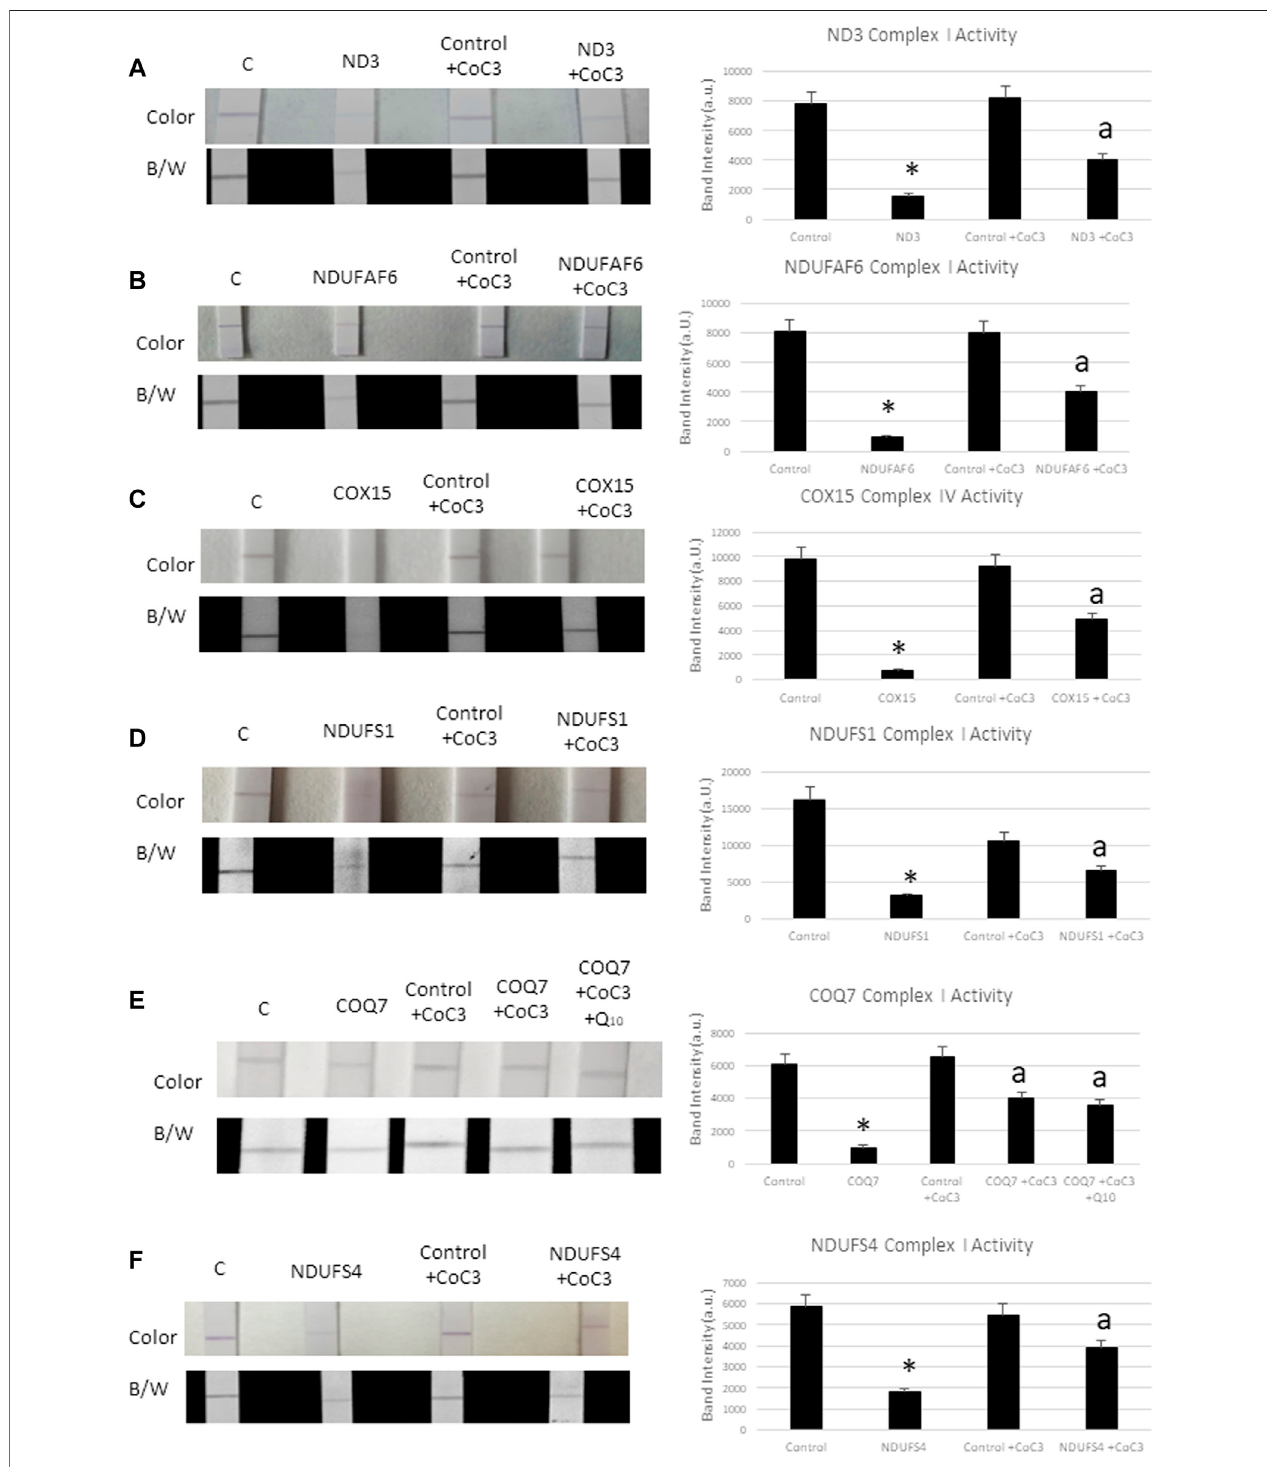
FIGURE 4 | Effect of CoC3 on complex I and complex IV activities in control and mitochondrial mutant fi broblasts. Complex I proteins ’ activities were measured using Complex I Enzyme Activity Dipstick Assay Kit from Abcam, with the exception of mutant COX15. In this particular mutation complex IV was measured. Mitochondrial complex activity in mtND3 cells (A) , NDUFAF6 cells (B) , COX15 cells (C) , NDUFS1 cells (D) , COQ7 cells (E) , NDUFS4 cells (F) . Results are shown in the dipstick images both incolour (bluish for complexI and yellowish for complexIV) and black/white. Band intensity wasquanti fi ed using the Image Lab software. “ C ” stands for healthy control cells. Fibroblasts were treated for 7 days with CoC3 treatment: 1 μ M Pterostilbene, 5 μ M nicotinamide, 1 μ M ribo fl avin, 1 μ M thiamine, 1 μ M biotin, 5 μ M lipoic acid and 1 μ M L -carnitine. * = p < 0.01 between Control and mutant fi broblasts. a p < 0.01 between untreated and treated mutant fi broblasts. a.u. (Arbitrary